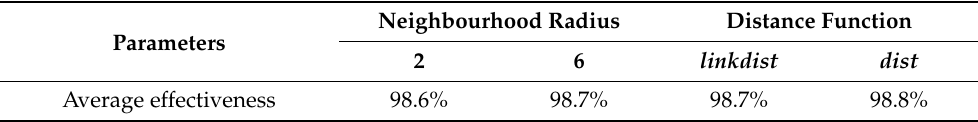
Table 7. Comparison of the effectiveness of the SOM-based fault detector for the 10 × 10 hexagonal map and the linkdist distance function for different values of the neighbourhood radius and for different distance function with the neighbourhood radius equal to 2.